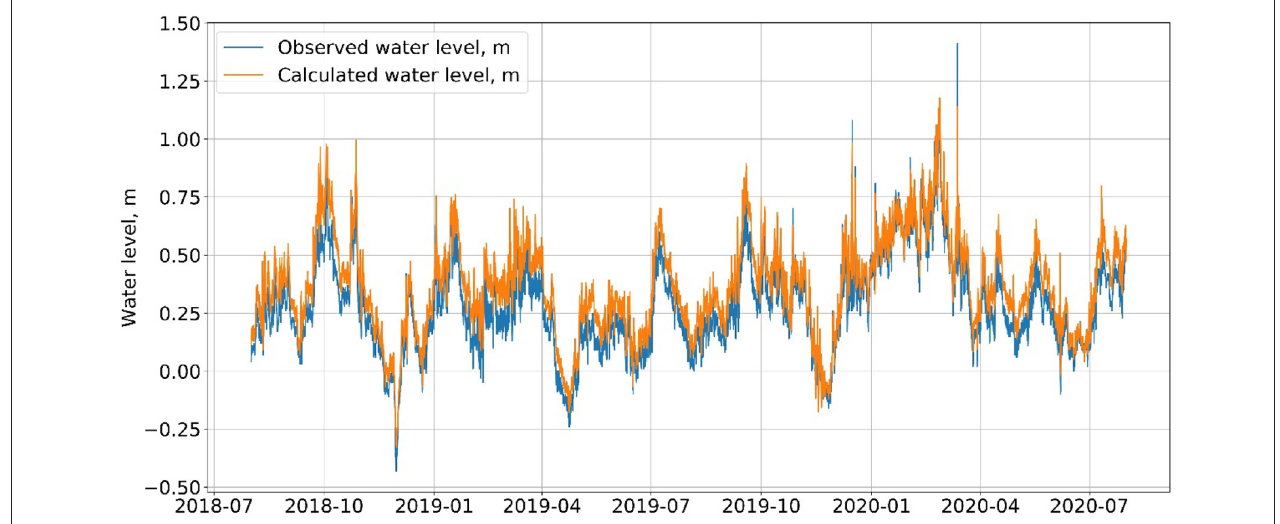
FIGURE 11 | Time-series of observed and calculated water level in the gauging station “Liepaja” located in the Trade